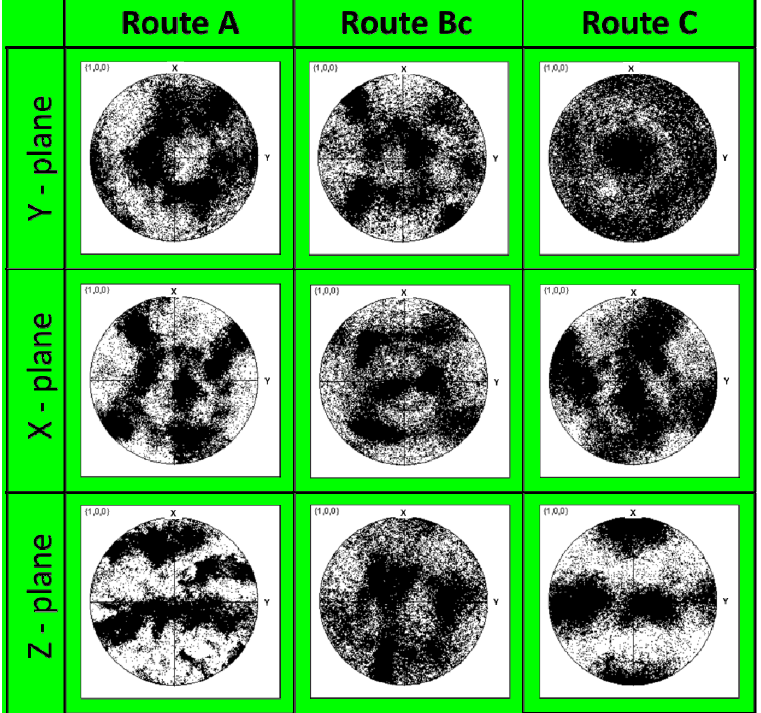
Figure 4. {100}-Pole figure of low CN Fe-20%Cr alloy after four passes of ECAP.